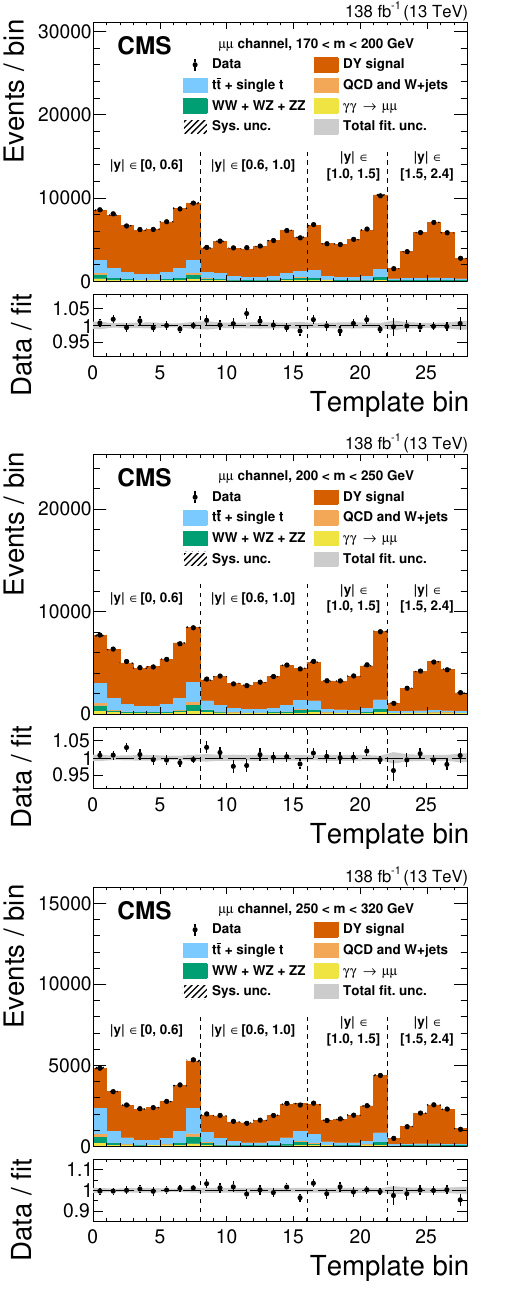
Figure 7 . The postfit distributions in the 170–200, 200–250 and 250–320 GeV mass bins are shown in upper, middle and lower rows, respectively. The left column is the mm channel, and the right column the ee channel. The contribution of the tt background is not visible on the scale of these plots and has been omitted. The 2D templates follow the cos θ and | y | binning defined in section 7 R but are presented here in one dimension, with the dotted lines indicating the different | y | bins. The black points and error bars represent the data and their statistical uncertainties. The bottom panel in each figure shows the ratio between the number of events observed in data and the best fit value. The gray shaded region in the bottom panel shows the total uncertainty in the best fit